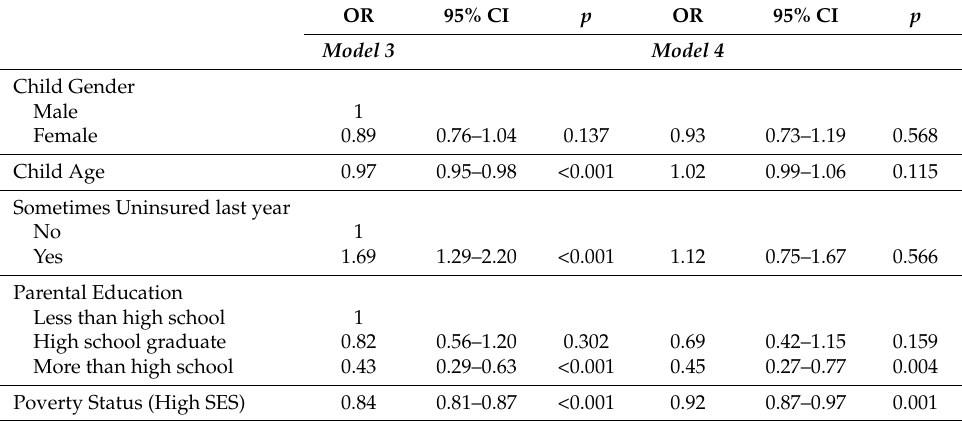
Table 4. Summary of logistic regression models in White and Black